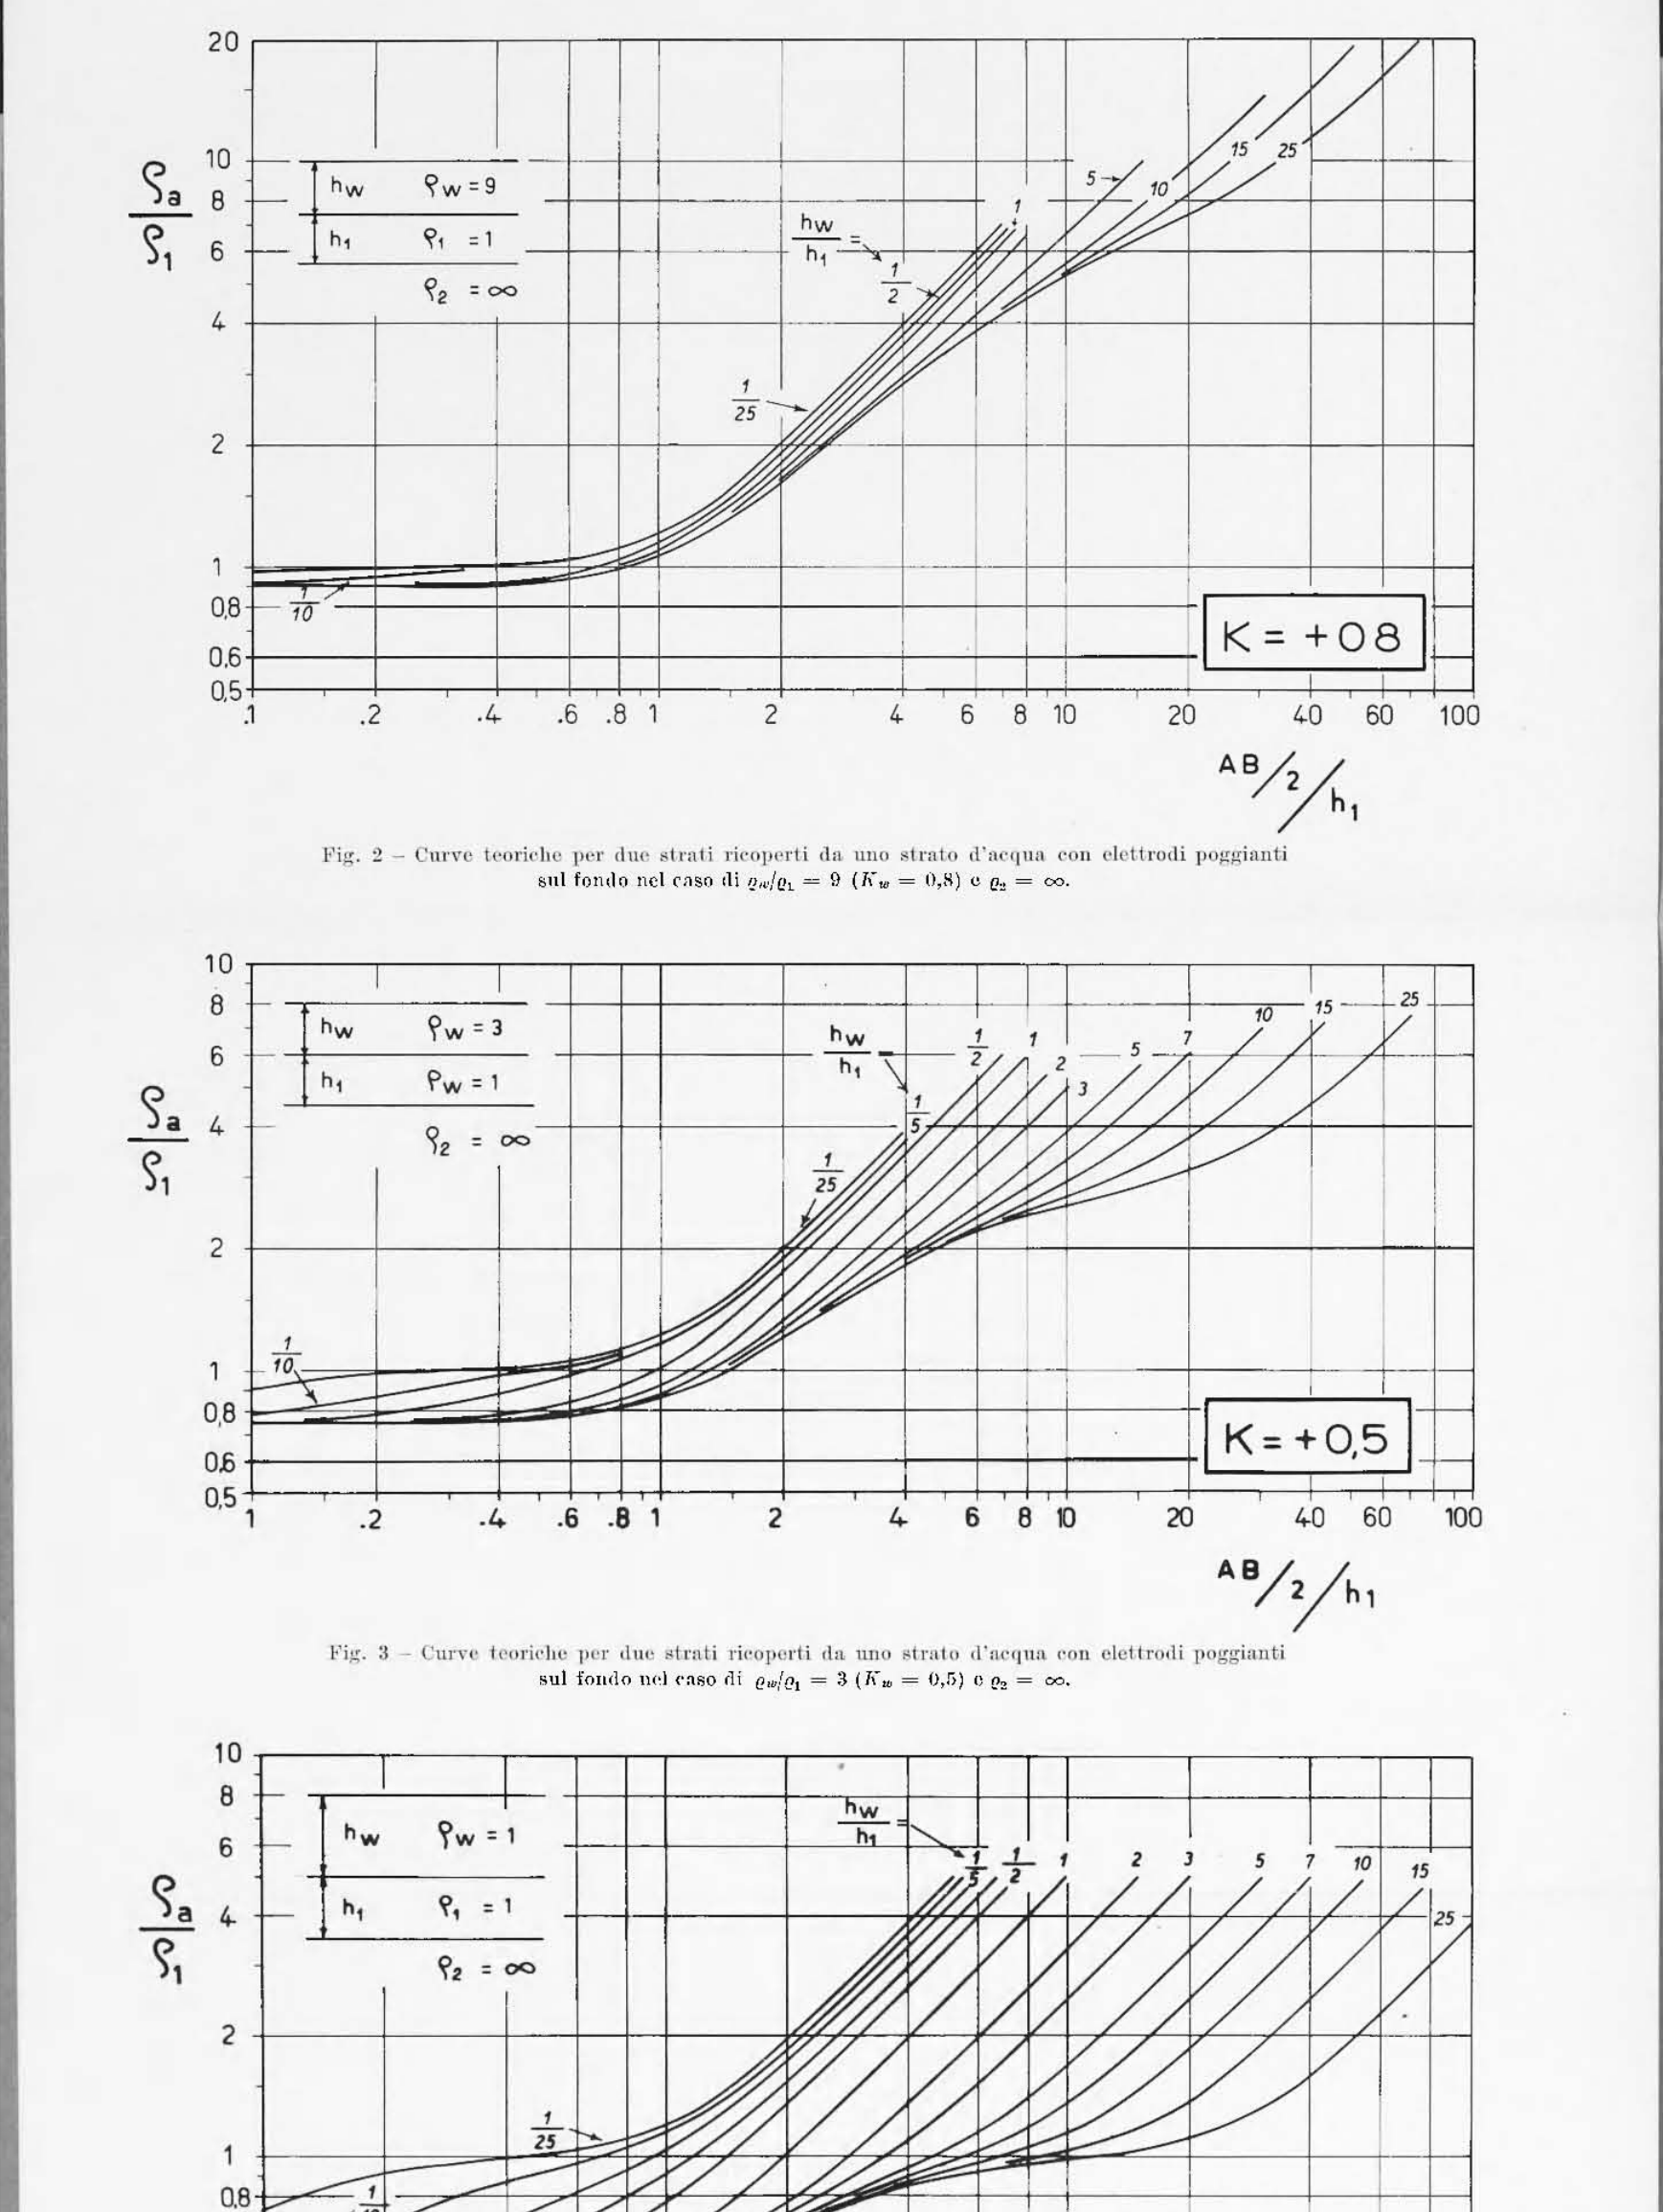
Fig. 4 - Curyc Il'orielle pPl' due strati J'kO]lcrti dil uno ~trilto d':wqna {'on (']ejtrodi poggianti sul fondo Ilt'l,'nso di ",,:'{l, = l (II," = O) e '.', =